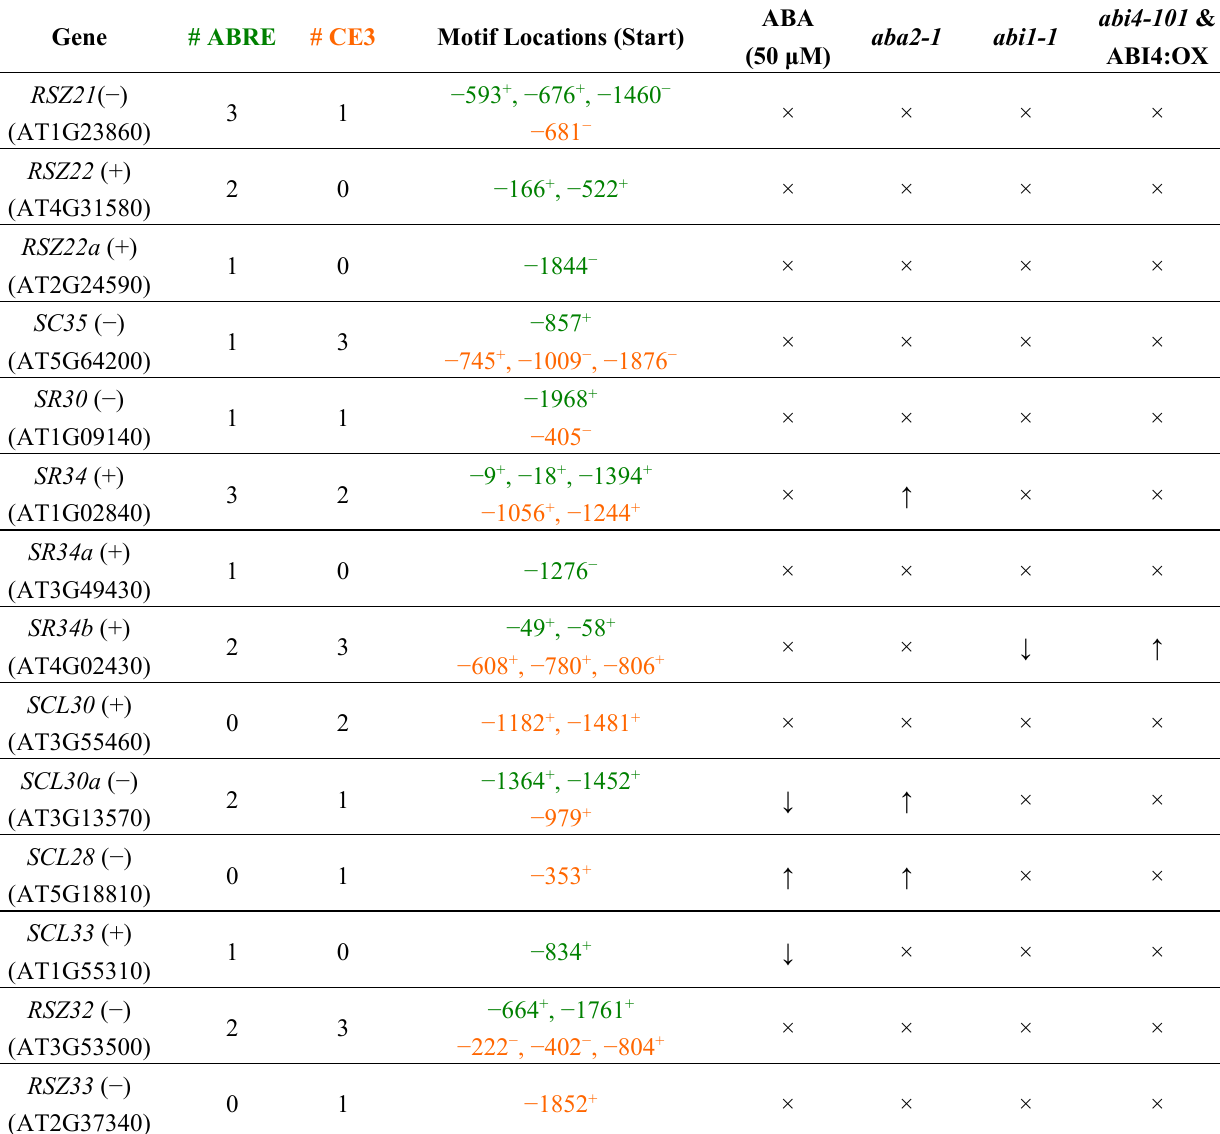
Table 1. ABA-responsive cis elements in 2 kb upstream sequences and corresponding expression changes under various ABA scenarios of Arabidopsis SR and SR-like genes. For each gene, the corresponding number of ABA-responsive elements (ABRE) and coupling elements (CE3) ( p < 0.0001), their locations within 2 kb of upstream sequence and whether the gene responds to ABA or genetic alterations of ABA pathway components are presented. The (+) and (−) signs next to the gene names denote the chromosomal gene orientation. Motif locations are presented as start coordinates upstream of the translation start site; ABRE locations are shown in green, whereas CE3 locations are presented below in orange. Superscripts to the right of the motif locations indicate if the motif was found on the forward (+) or reverse (−) strand of the upstream sequence. Upward- and downward-pointing arrows indicate significant induction or repression of gene expression, respectively, in response to various ABA scenarios (see Figures